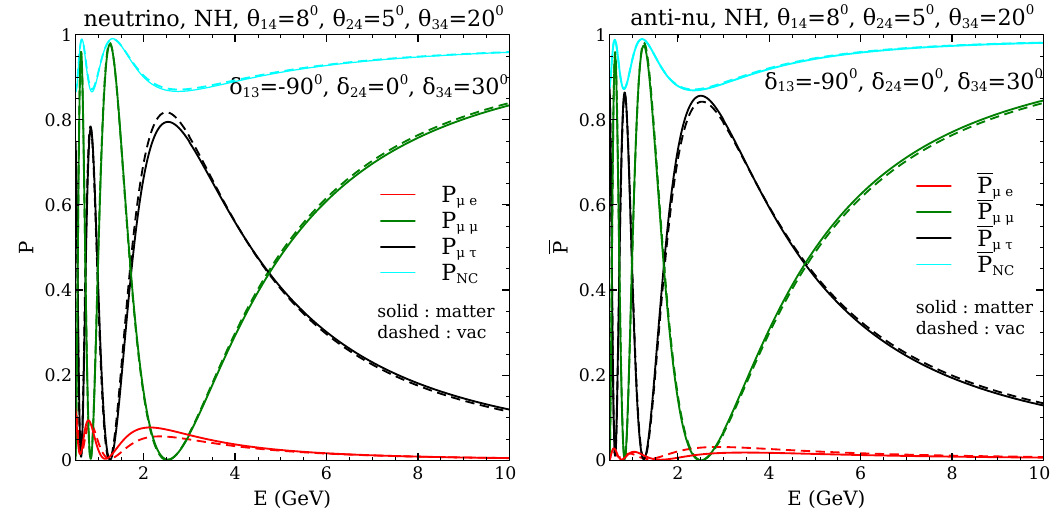
Figure 3 . Probability plots, comparing P (cid:22)e ; P (cid:22)(cid:28) ; P (cid:22)(cid:22) and P NC = 1 (cid:0) P (cid:22)s , all for the 3+1 model, using GLoBES. The left panel is for neutrinos and the right one for anti-neutrinos, and solid curves are for matter while the dashed ones are for vacuum. Choices of phases and mixing angles have been made as shown. The curves correspond to L = 1300 km.